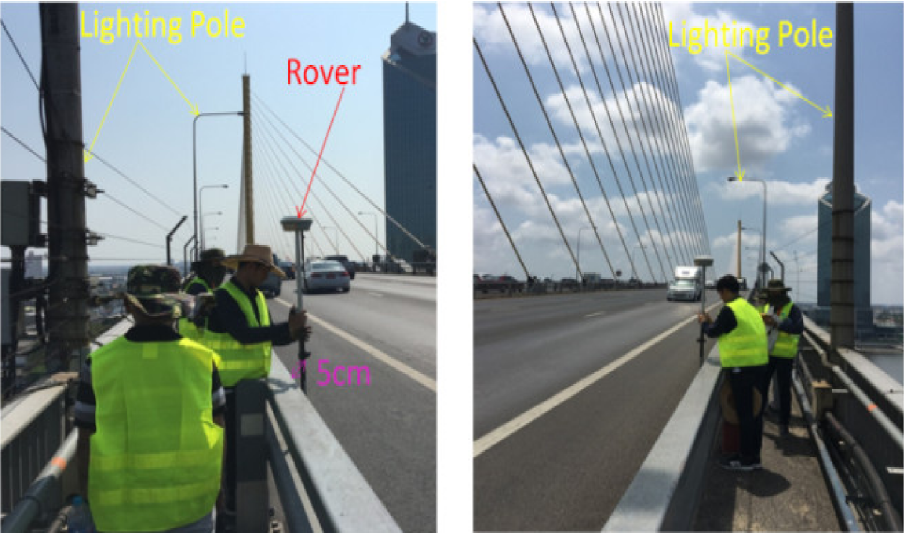
Figure 10. A real-time kinematic survey in progress.